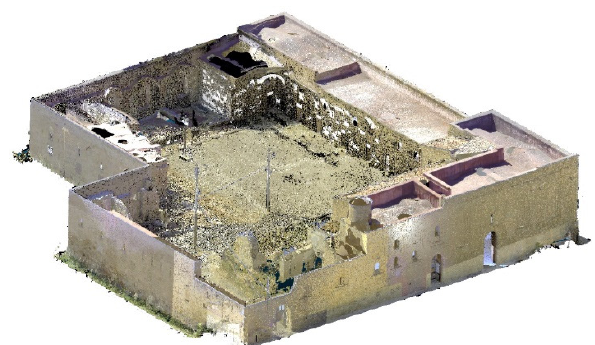
Figure 7: Final point cloud of the Castle of